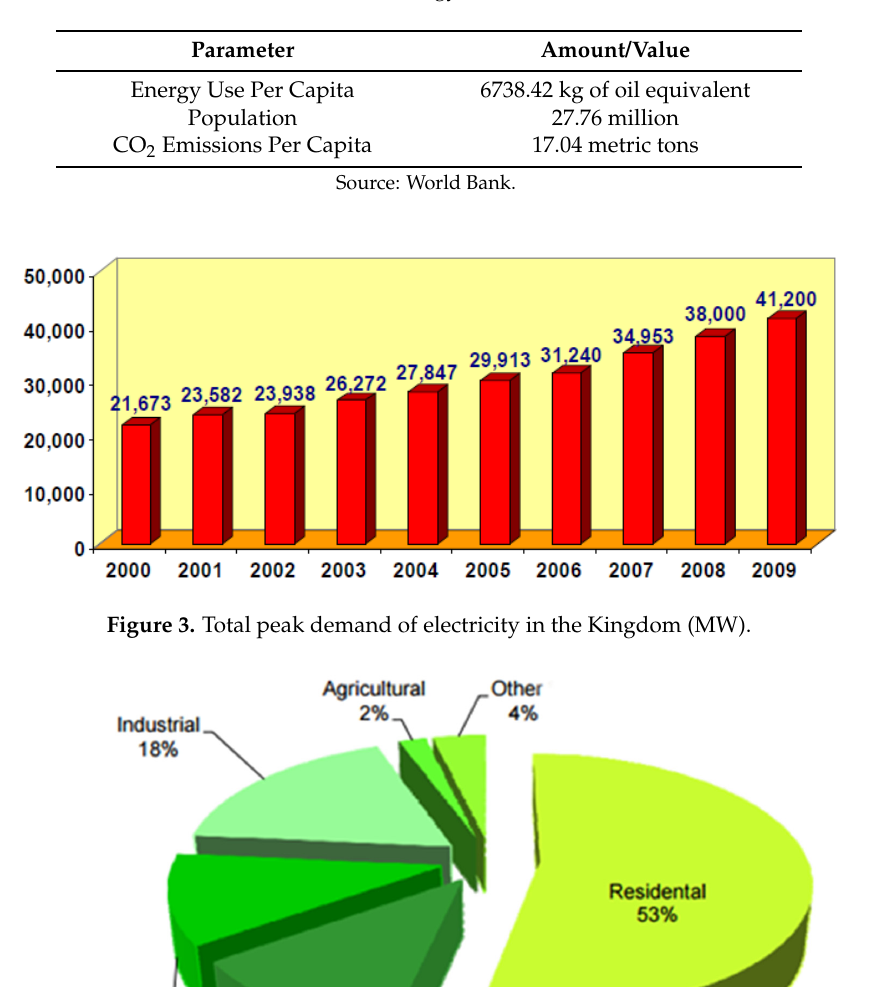
Figure 4. Electricity consumption by sector (Source: Ministry of Water and Electricity).